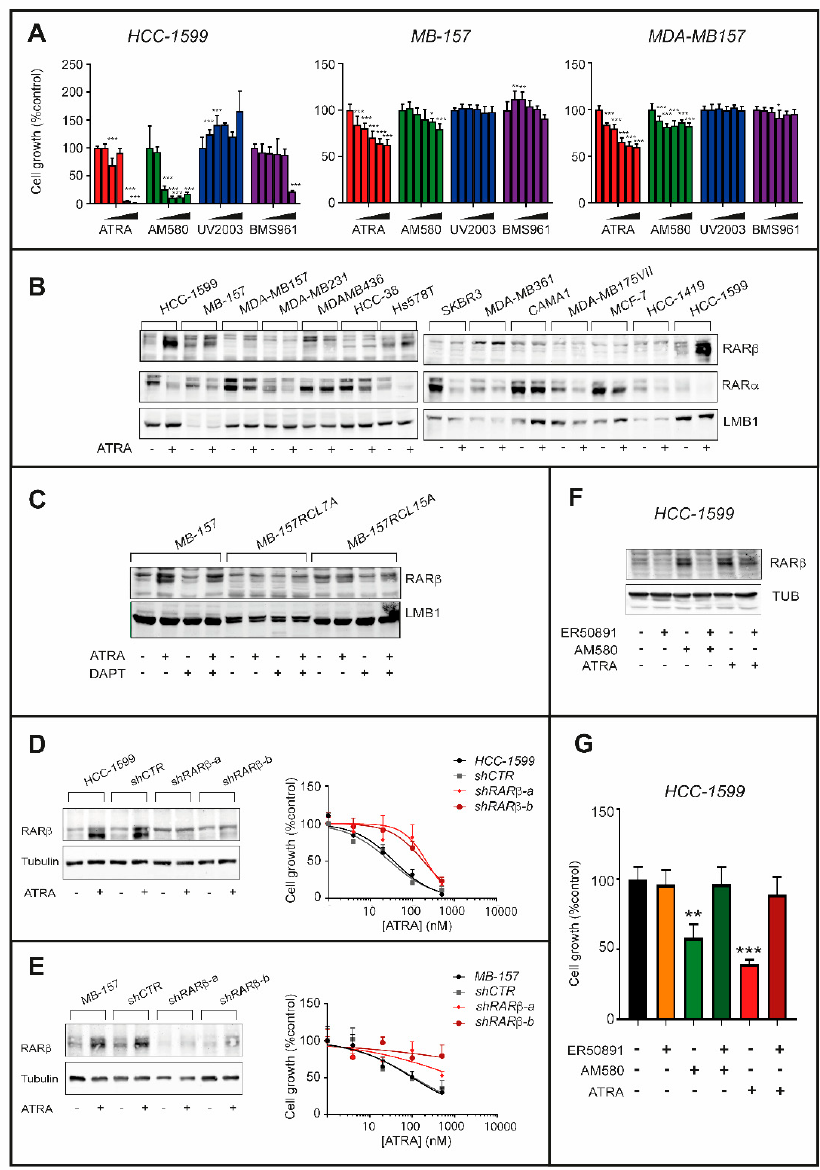
Figure 8. Involvement of RAR β in the anti-proliferative action exerted by ATRA in HCC-1599 and MB-157 cell lines. ( A ) The indicated cell lines were challenged with vehicle (DMSO) and increasing concentrations of ATRA (1.0 μ M, 0.3 μ M, 0.1 μ M, 0.03 μ M and 0.01 μ M), the RAR α agonist, AM580 (1.0 μ M, 0.3 μ M, 0.1 μ M, 0.03 μ M and 0.01 μ M), the RAR β agonist, UVI2003 (1.0 μ M, 0.3 μ M, 0.1 μ M,